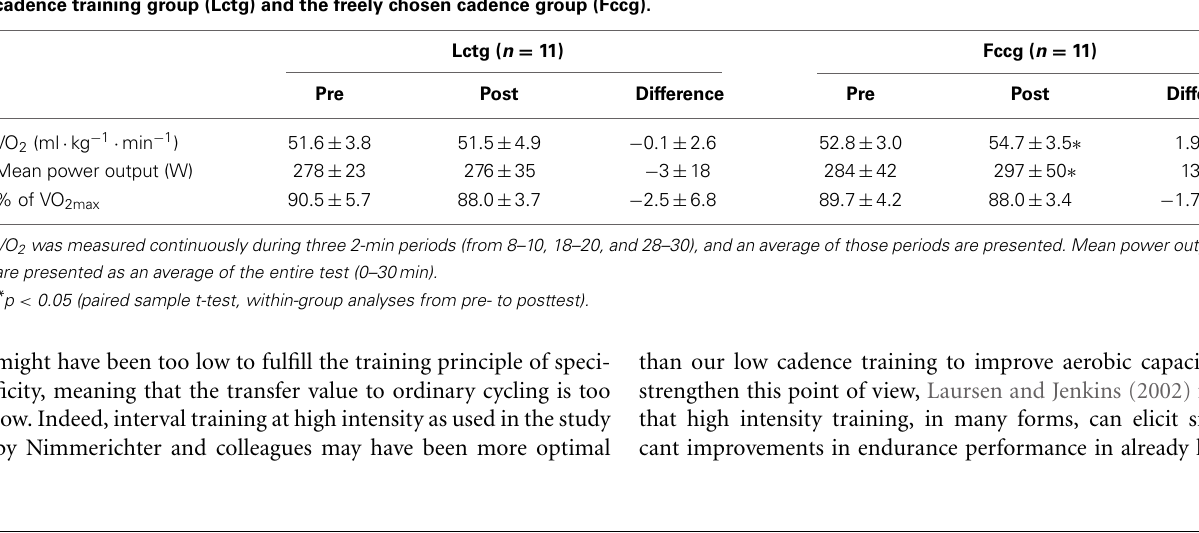
Table 4 | Oxygen consumption (VO 2 ) (mean ± SD ) during the 30min performance test pre and post training intervention period for the low cadence training group (Lctg) and the freely chosen cadence group